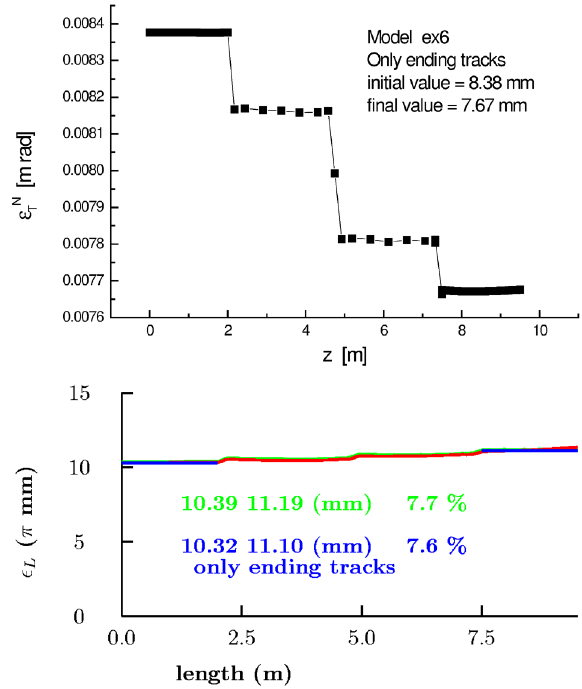
FIG. 50. (Color) Results from ICOOL simulation of MICE: normalized transverse (top) and longitudinal (bottom) emit- tances vs distance.